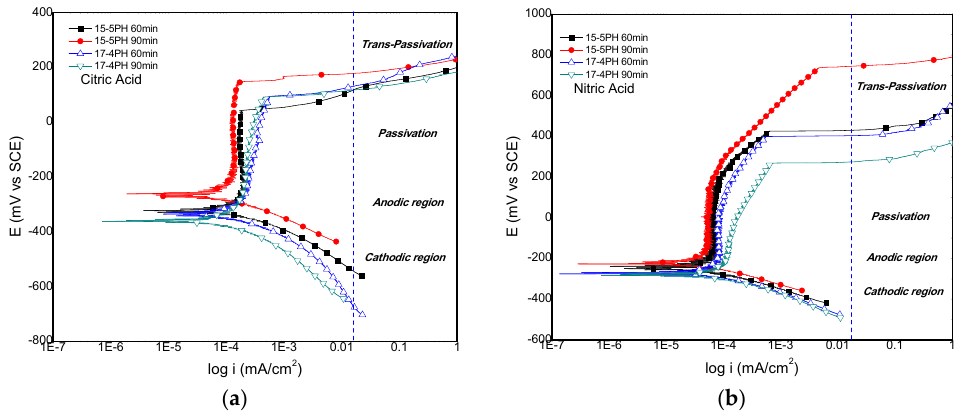
Figure 5. Potentiodynamic polarization curves of 15-5PH and 17-4PH stainless steel passivated in ( a ) citric acid and ( b ) nitric acid, exposed in a 5 wt. % NaCl solution at 49 °C. The parameters (E corr , E pitt , i corr , and corrosion rate (C.R.)) obtained from the polarization potentiodynamic curves are summarised in Table 4. Very low values of corrosion rate (within the same order of magnitude) were recorded for both 15-5PH and 17-4PH steels, irrespective of the passivation treatment conditions. Table 4. Potentiodynamic polarization parameters in stainless steels passivated at 49 °C, in 5 wt. % NaCl.